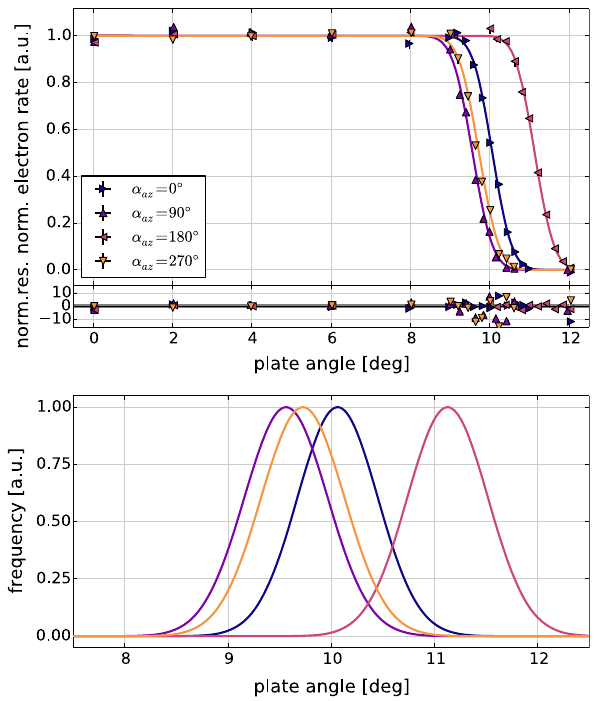
Fig. 8 Measured magnetic reflection curves ( top ) and angular distri- butions ( bottom ) for different azimuthal angles of the source. The spec- trometerwasoperatedwith U spec = − 18 . 6kVand B + start = 27mTatthe electron emission spot. The given residuals are in absolute units. Large pitch angles are cut off from the transmission function due to magnetic reflection at the spectrometer solenoids ( B max = 6T). By increasing the plate angle α p , the transmission probability decreases until all elec- trons are reflected. The point of reflection depends on the ratio of the magnetic fields, B start / B max . The angular distributions shown are given in terms of plate angle ( α p ); the actual angular spread in terms of pitch angle ( θ mag ) is σ θ ≈ 16 ◦